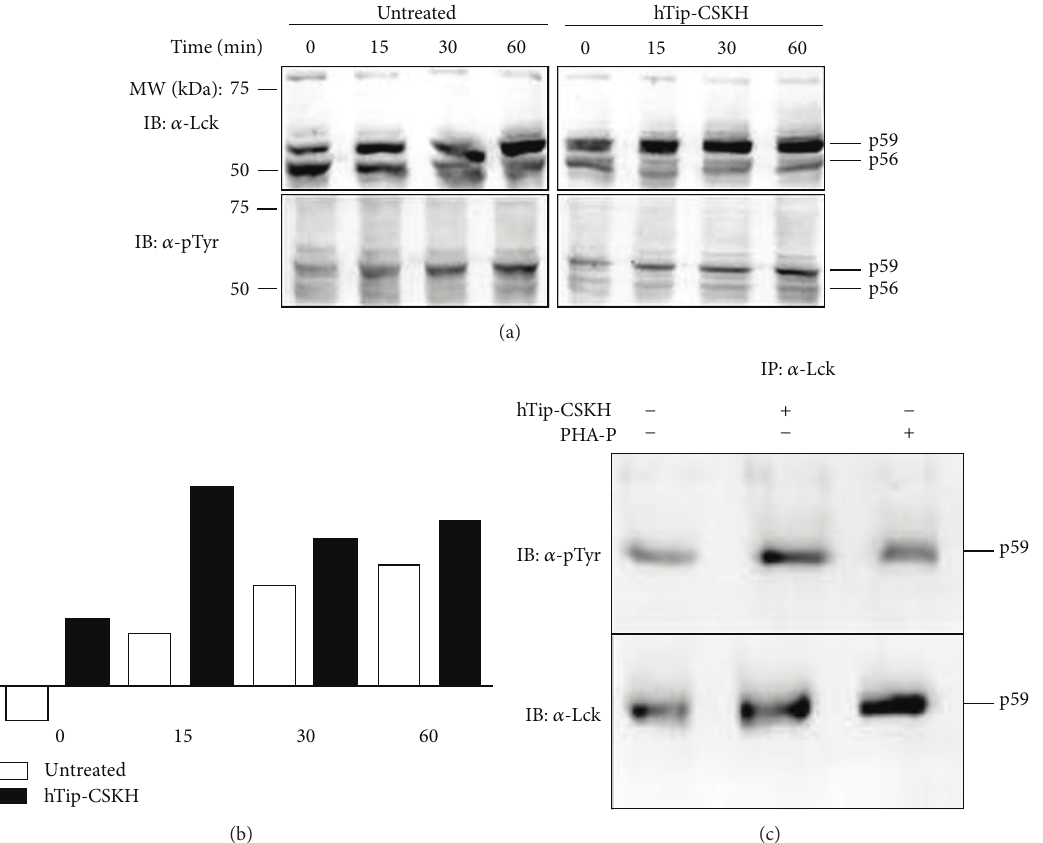
Figure 6: Time-course assay for Lck in human PBMC after cell stimulation. (a) PBMC either untreated (lanes 1–4) or treated (lanes 5–8) for 1h with hTip-CSKH were stimulated with PHA-P for 0, 15, 30, and 60 min and then were lysed. Extracts were subjected to SDS-PAGE and proteins transferred to PVDF membranes. WB was performed with Lck (upper panels) and P-Y (lower panels) monoclonal antibodies. Two bands were clearly defined which correspond to the low molecular weight (p56) and the high molecular weight band (p59), respectively. (b) Quantification of p56 and p59 bands showed an increase of the p59/p56 ratio. White bars represent nontreated cells and black bars hTip- CSKH-treated cells p59/p56 ratio at different time points. (c) Lck immunoprecipitation of PBMC extracts after stimulation with PHA-P or hTip-CSKH for 30 min. WB was performed with monoclonal antibodies against pTyr and Lck as